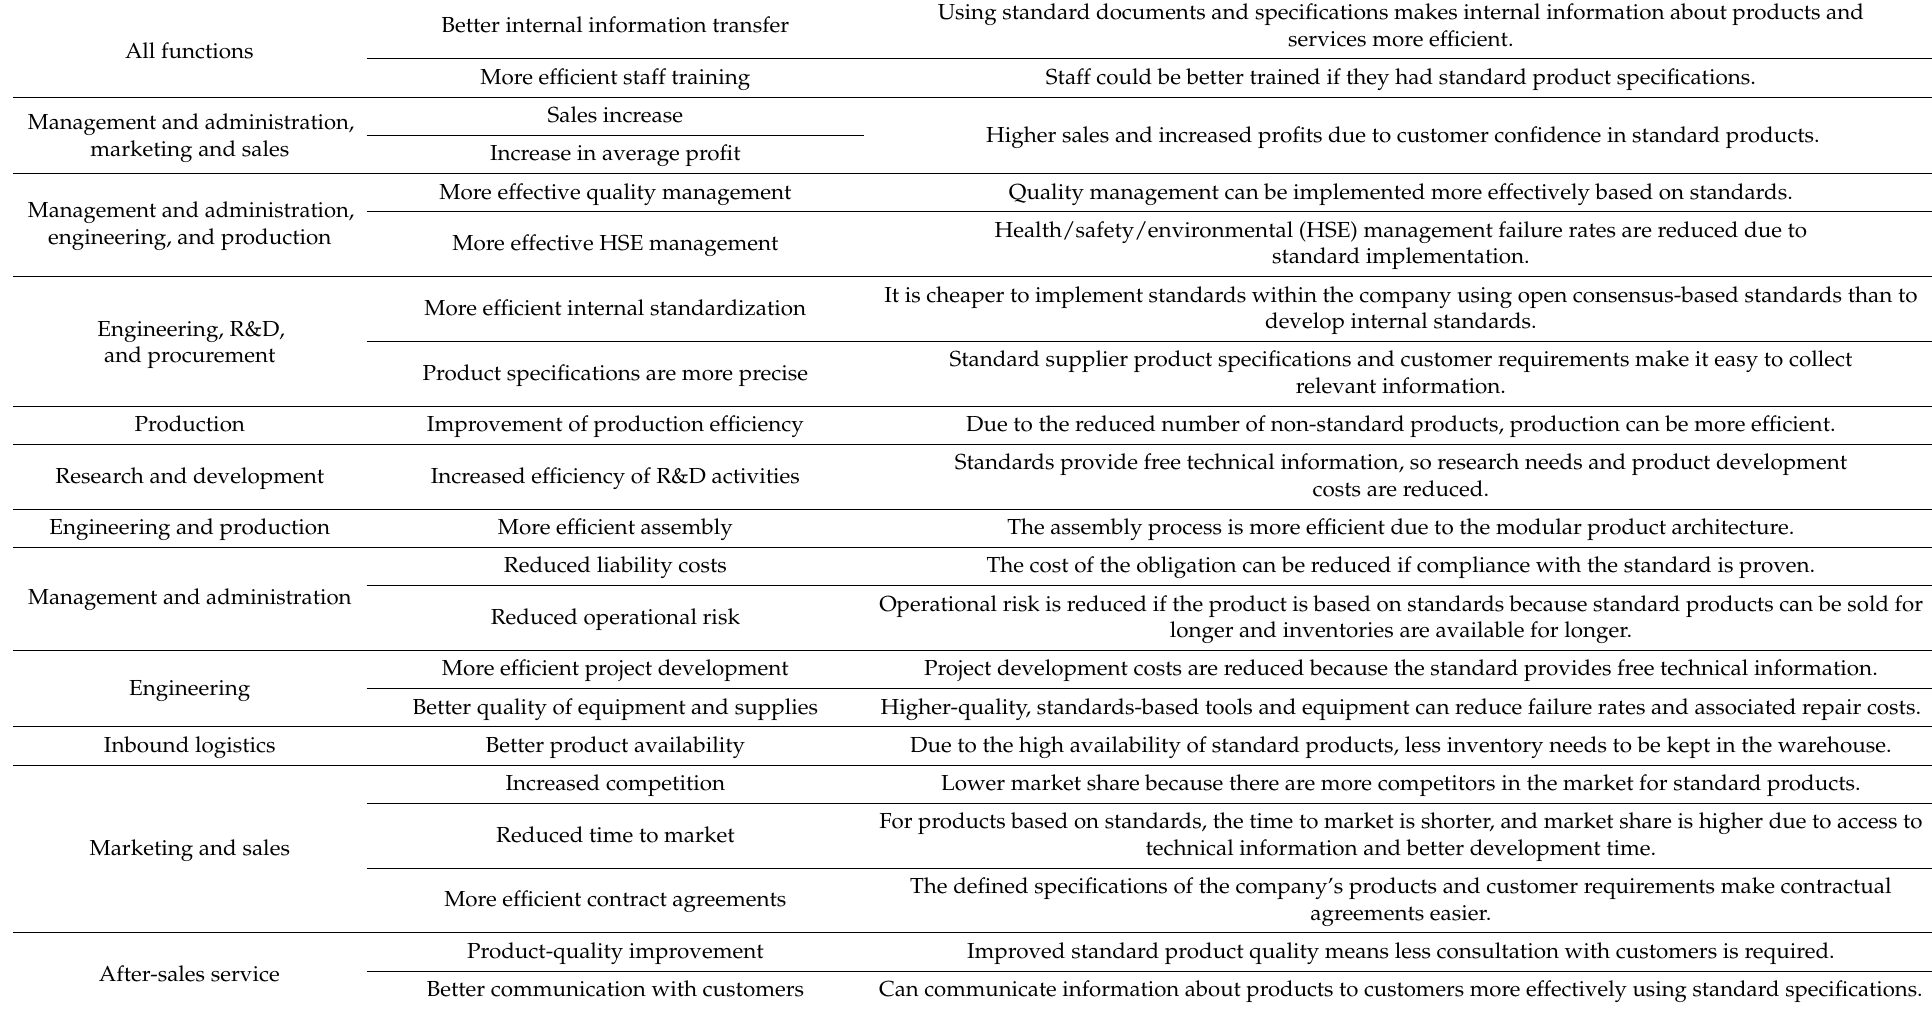
Table 2. Operationalization of economic-benefit assessment